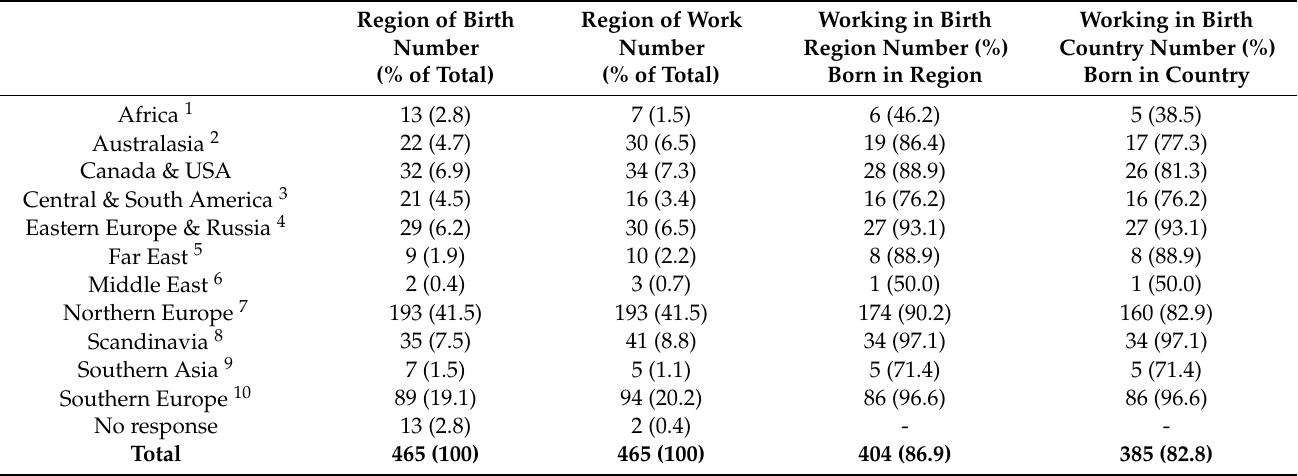
Table 2. Regions of birth and work (Q6 and